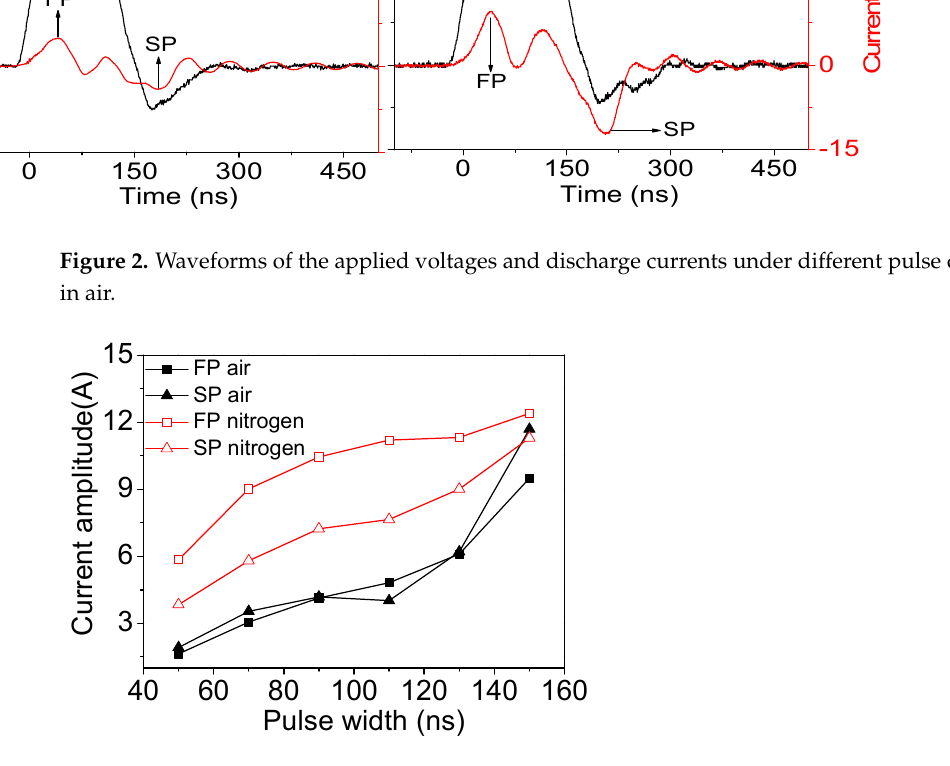
Figure 3. Effects of pulse duration on the peak values of the first and second discharge currents under air and